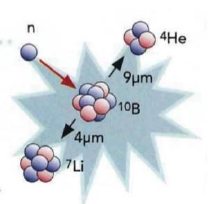
Fig. 1. Boron Neutron Capture nuclear reaction